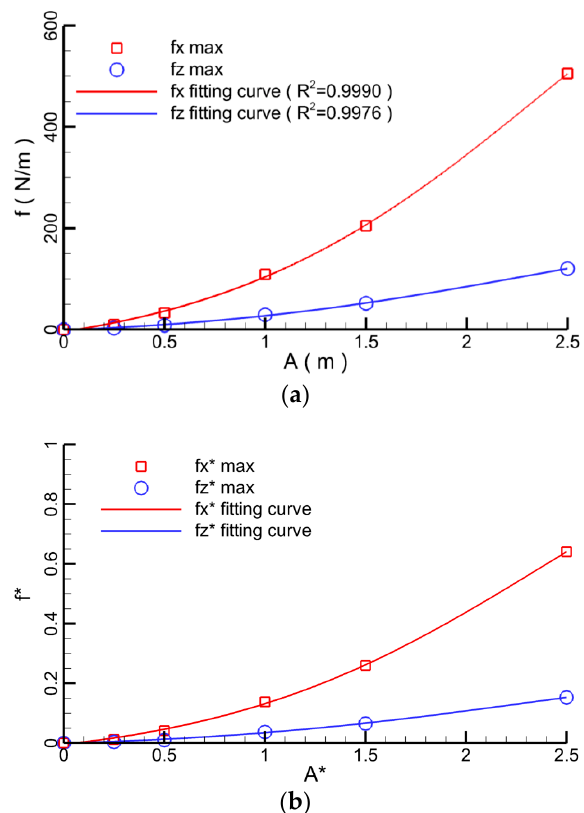
Figure 18. The hydrodynamic force on pipeline with different tidal amplitudes. ( a ) Maximum force. ( b ) Non-dimensional maximum force.